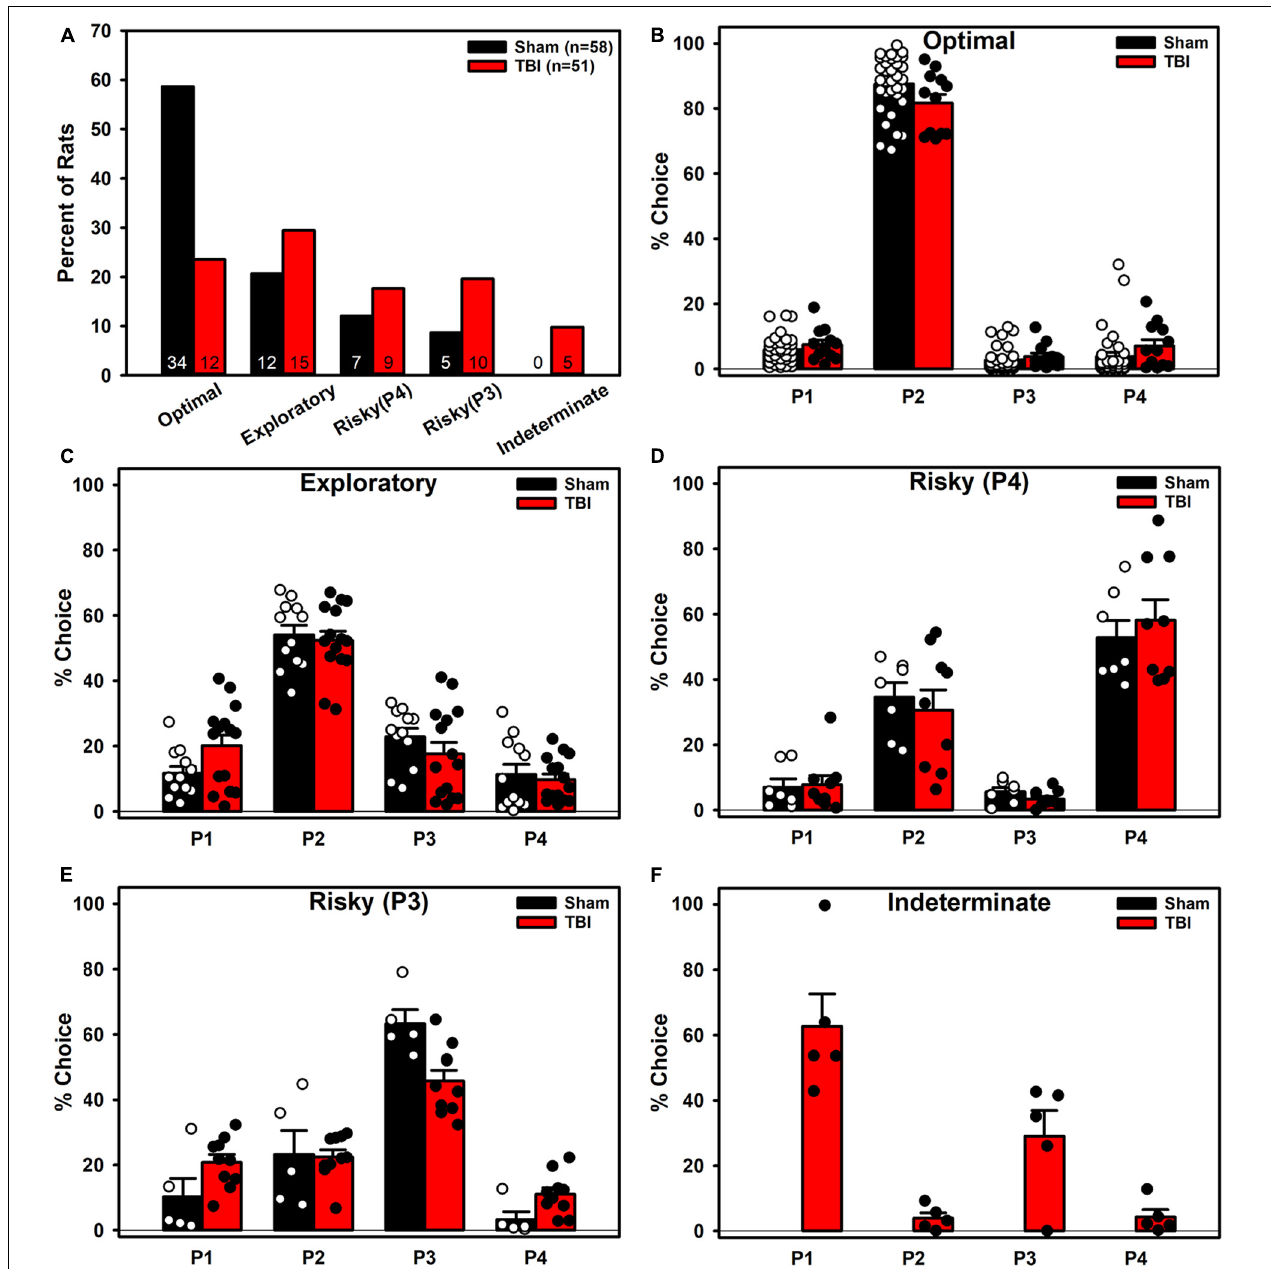
FIGURE 7 | Phenotypes broken down by Injury. (A) TBI rats were significantly less likely to be in the Optimal phenotype and instead were increased across the other phenotypes. Only TBI rats were classified into the Indeterminate phenotype. (B) TBI was significantly different than Sham ( p = 0.018) in the Optimal phenotype, with lower P2 and higher P4 choice. (C) TBI was not significantly different than Sham but had high variability in the Exploratory phenotype. (D) TBI was not significantly different than Sham but had high variance in the Risky (P4) phenotype as well. (E) TBI was significantly different than Sham ( p = 0.001), with higher P1 and lower P3 preference in the Risky (P3) phenotype. (F) Only TBI animals were present in the Indeterminate